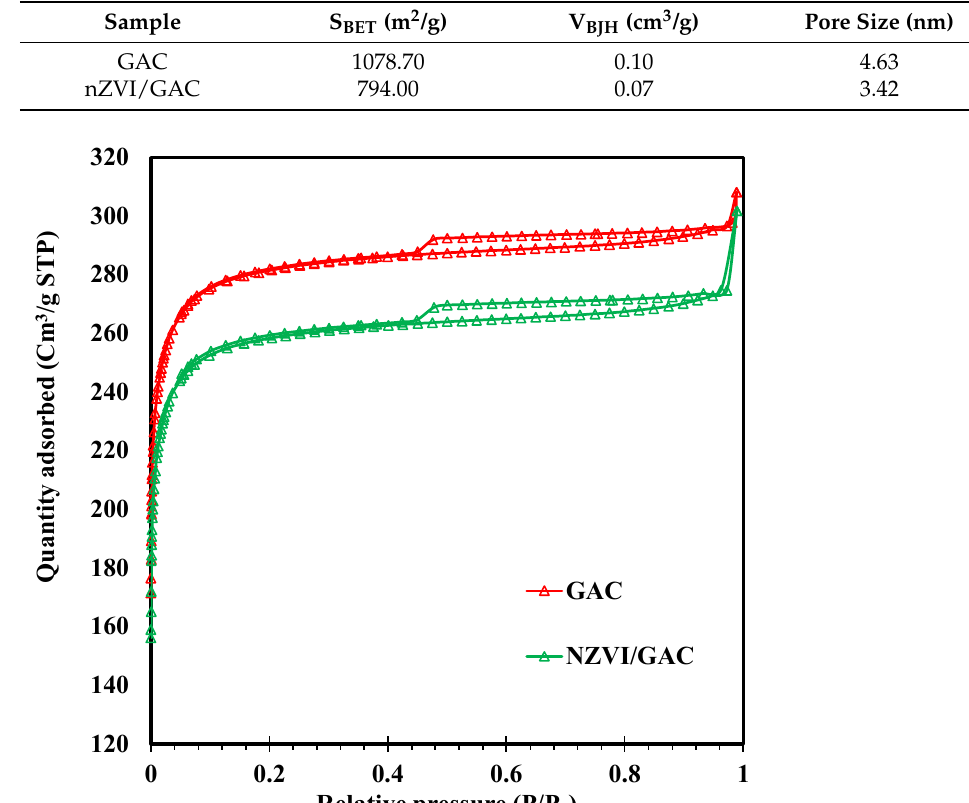
Table 1. Textural structure parameters of GAC and nZVI/GAC.